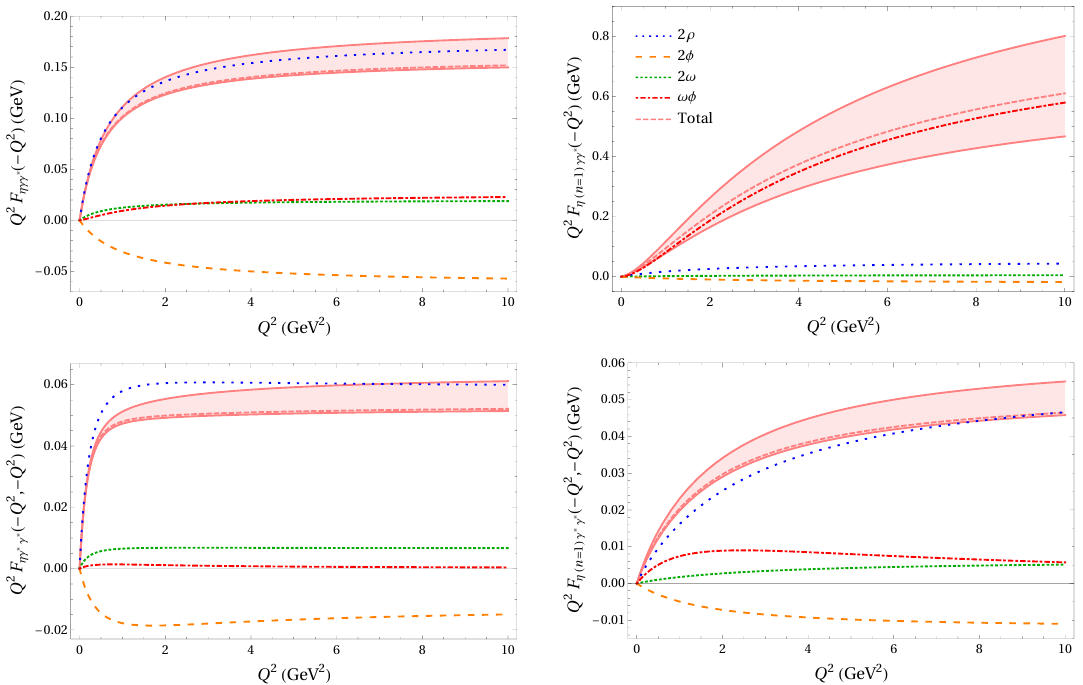
Figure 30. 2 (cid:26) , 2 ! , 2 (cid:30) , and (cid:30)! contributions to the singly-virtual (top) and doubly-virtual (bottom) (cid:17) ground state (left) and (cid:12)rst excited state (bottom). In the left panel of (cid:12)gure 30, the ground-state (cid:17) TFF is decomposed into the contribu- tions from 2 (cid:26) , 2 ! , 2 (cid:30) , and (cid:30)! vector mesons. As expected, the TFF is dominated by the isovector-isovector 2 (cid:26) contribution, followed by the isoscalar-isoscalar 2 (cid:30) contribution. The (cid:30)! contribution (4.36), which was needed to generate enough freedom in our large- N